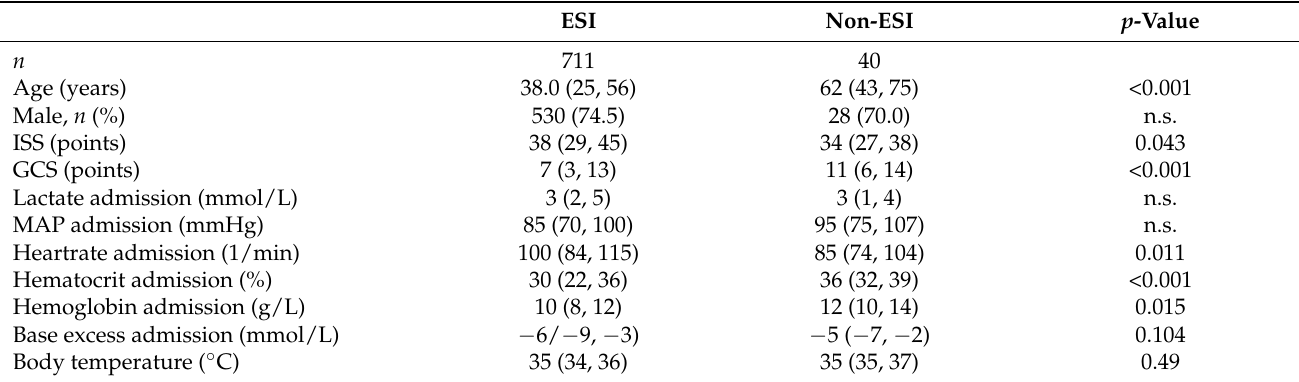
Table 1. Demographics and injury description of the study population.